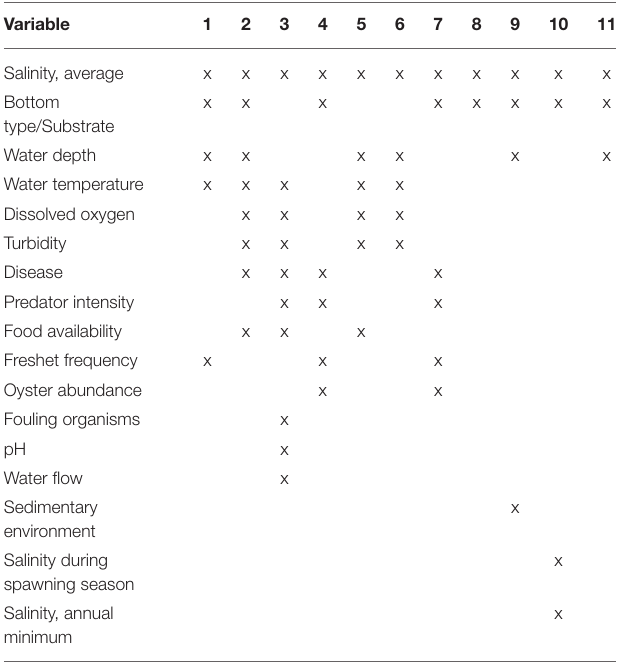
TABLE 2 | Variables used in habitat suitability index models developed for oyster aquaculture, fishery production and restoration, and the models using each